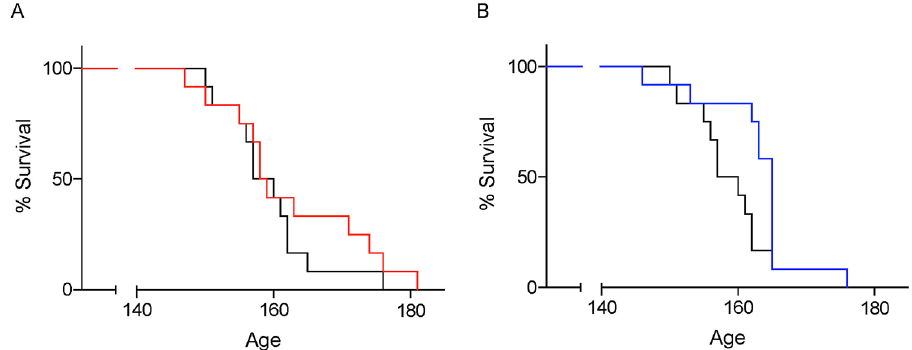
Figure 4. The lifespan of oxaloacetate-treated SOD1 G93A mice. ( A ) The median end-stage age of oxaloacetate treatment of SOD1 G93A mice from the presymptomatic stage (60 days old, red) was 158.5, which was the same as the control group of non-injected SOD1 G93A mice (black, p = 0.3717, log-rank test). ( B ) The median end-stage age of oxaloacetate treatment from the symptomatic stage (110 days old, blue) was 165 days. This median age was not statistically different from the control group ( p = 0.051, log-rank test). The graphs show Kaplan–Meier curves with n = 12 mice per group. These graphs contain mice that are identical to the mice in Fig.